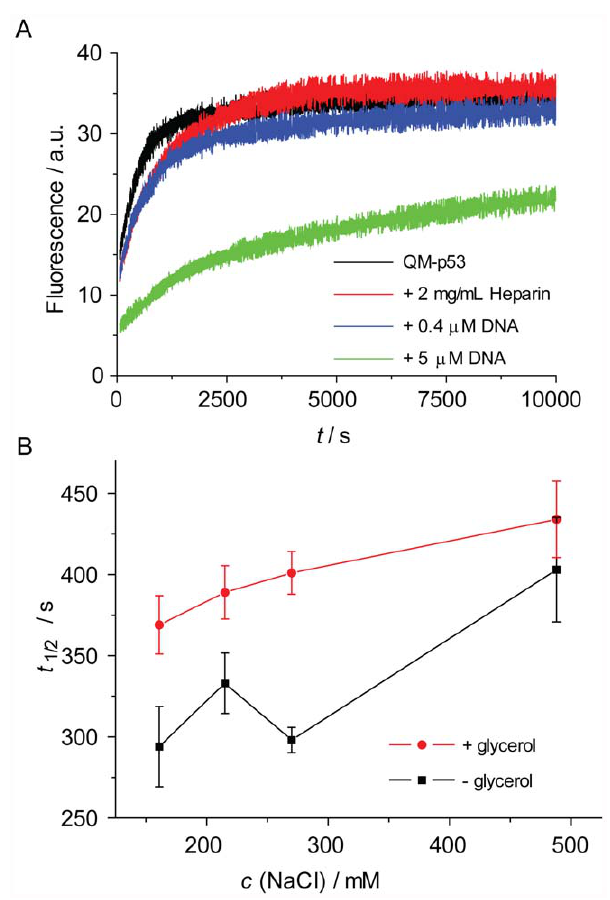
Figure 3. Kinetic stabilisation of p53. A: Raw data for QM-p53 alone (black), with added heparin (red) and with added DNA (0.4 m M, blue; 5 m M, green). B: Comparison of half-lives of QM-p53 at different NaCl concentration without (black) and with 10% glycerol